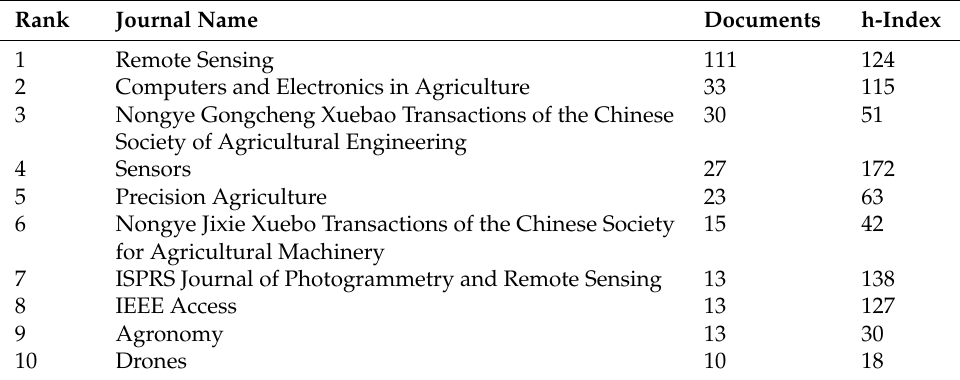
Table 3. Most preferred journals on adopting UAV-PA.